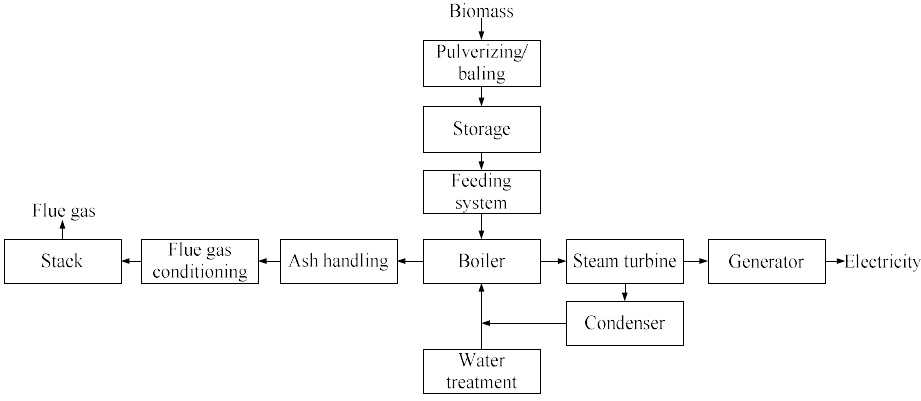
Figure 1. Typical flow for biomass combustion power generation project.